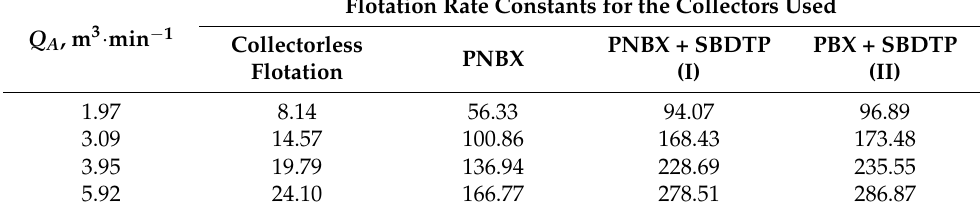
Table 6. Established flotation rate constants for